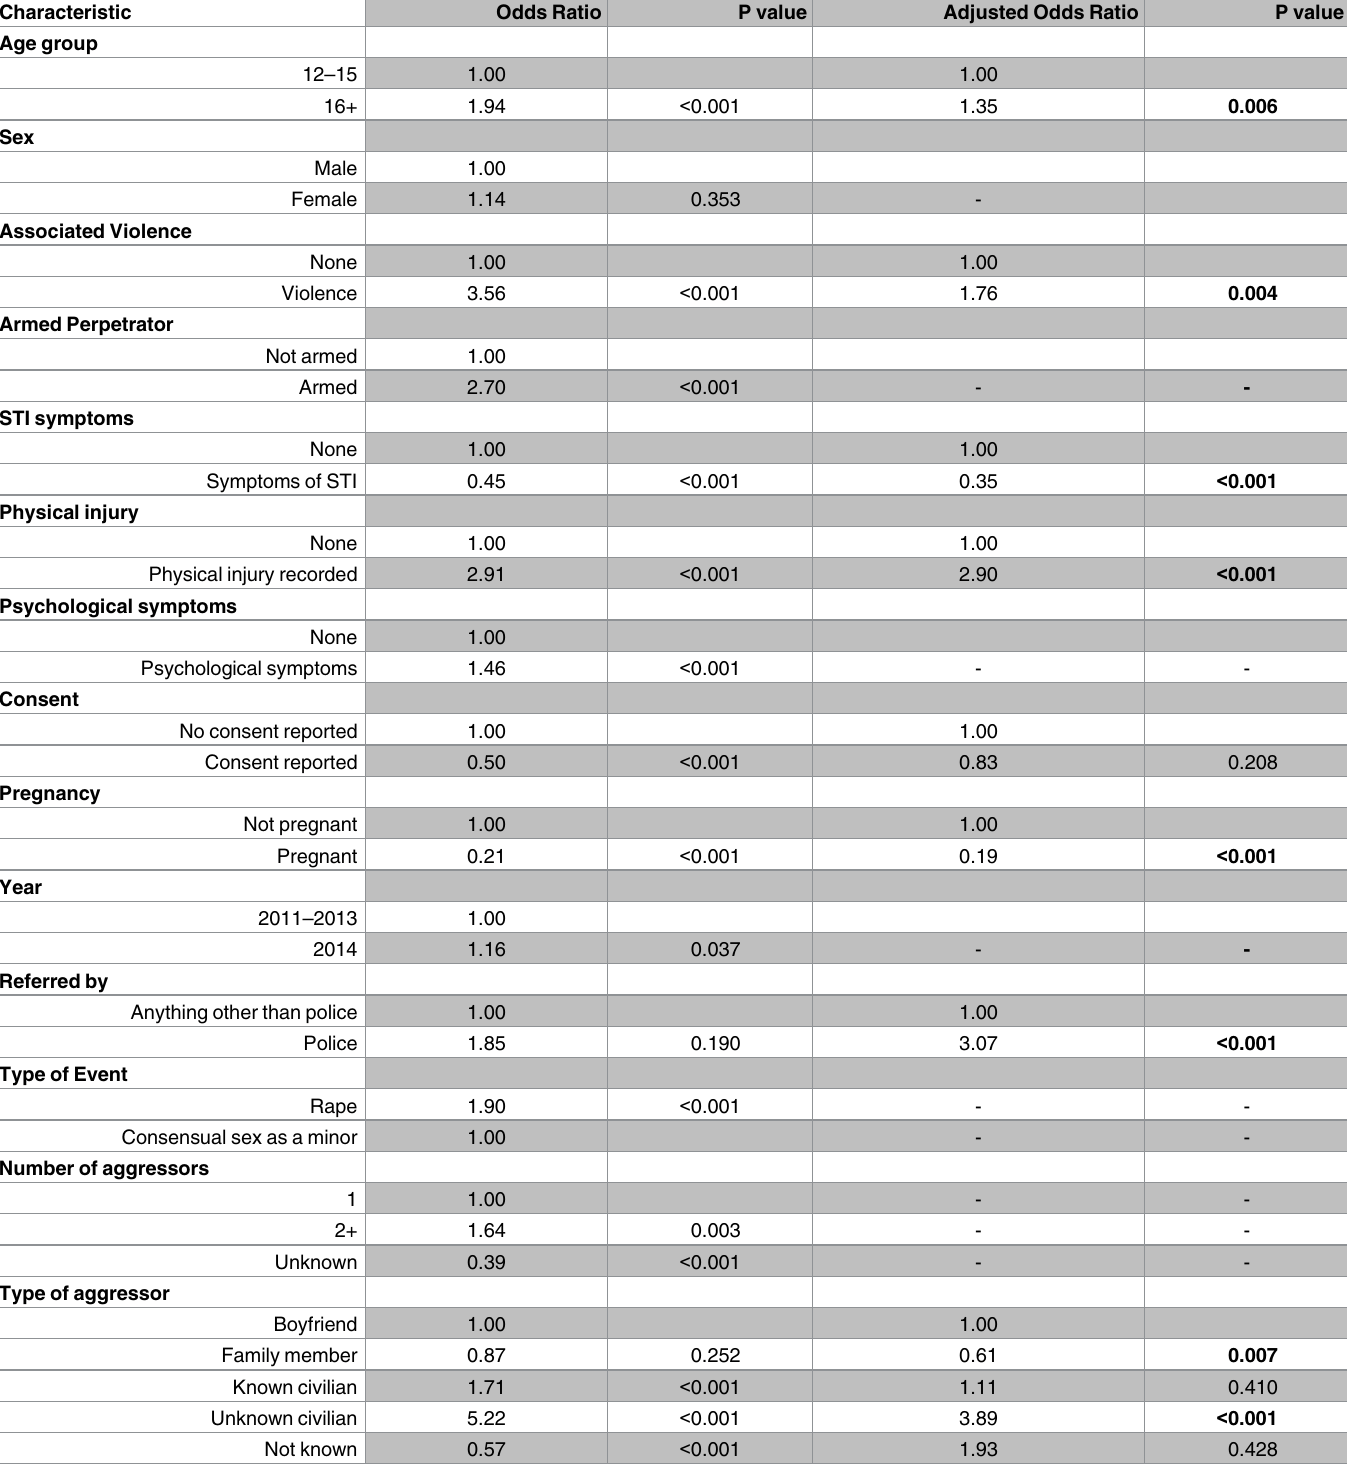
Table 3. Factors associated with presentation within 72 hours after an incident of sexual violence, Mbare SGBV clinic (09/11–12/2014).